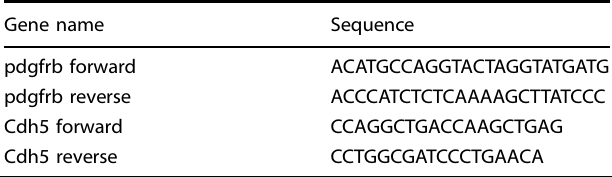
Table 3. The primer sequences used to determine the genotypes